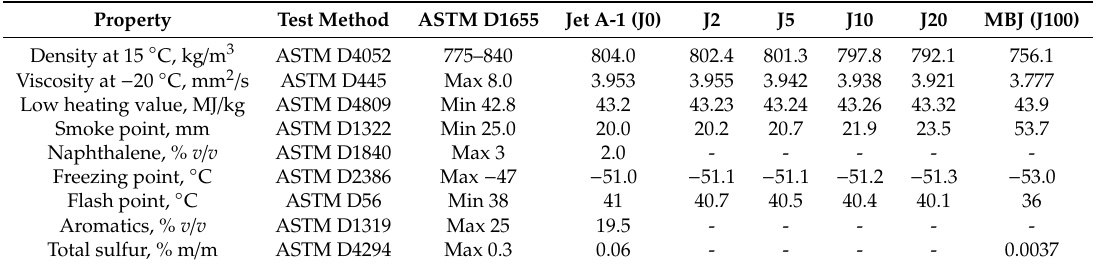
Table 3. Typical properties of Jet A-1 and MBJ. Developed from [32].